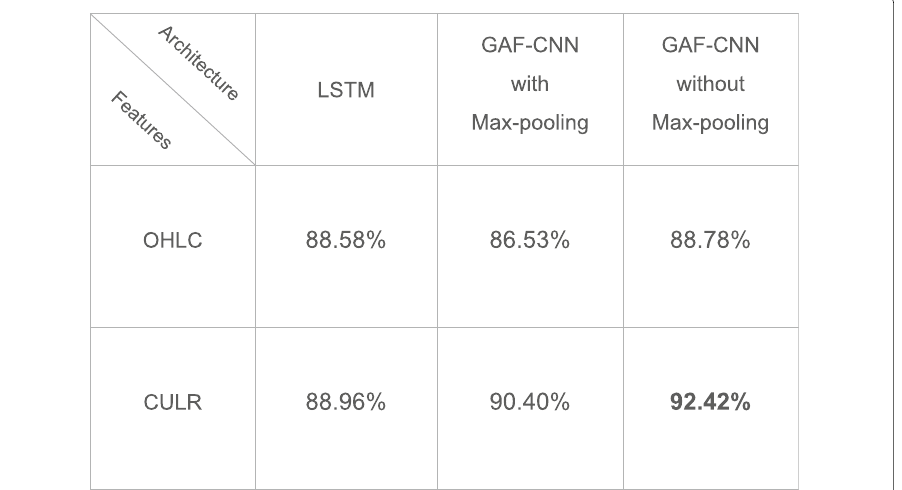
1. the opening, high, low, closing prices (OHLC); and 2. the closing prices, upper shadow, lower shadow, real-body (CULR). The result of using (2) closing, upper shadow, lower shadow, and real-body (CULR) can achieve 92.42% average accuracy. If we focus on the result from class 1 to class 8, then the performance is 95.43% accuracy on average.